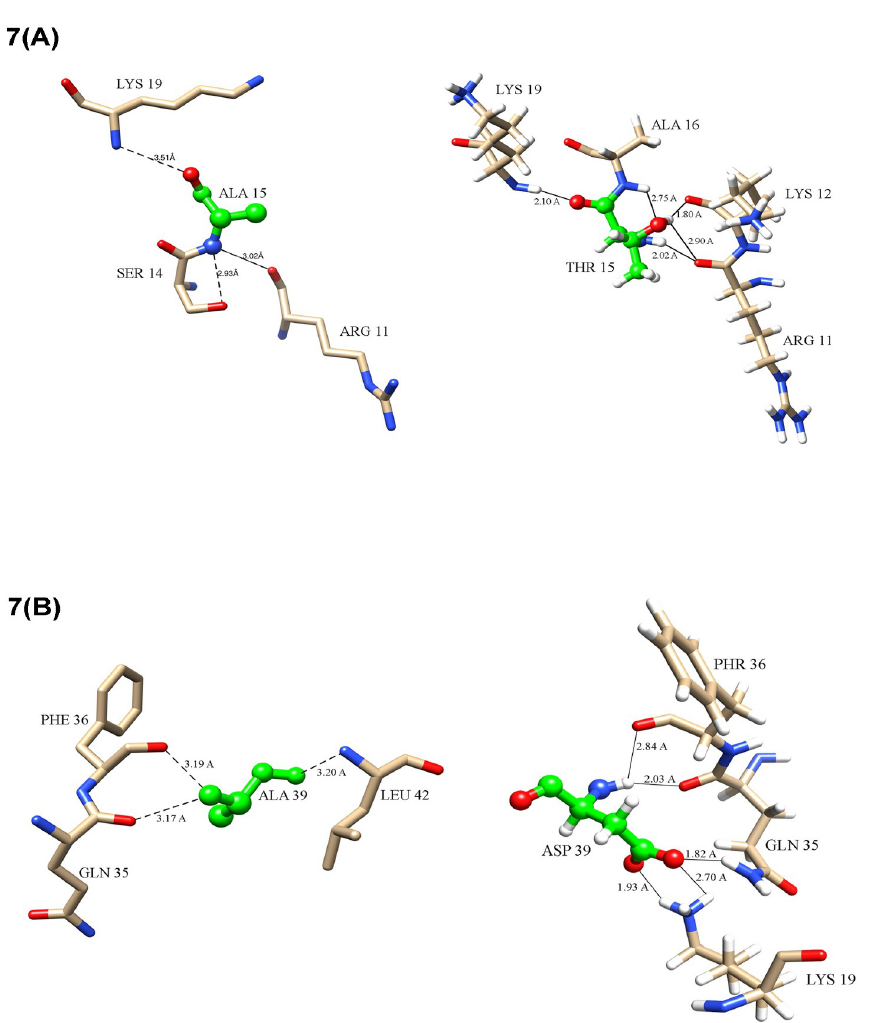
Fig 7. Protein ligand interaction (A) A15T mutation gained some new interaction and loses some native interaction; (B) A39D interaction also gained some new interaction.